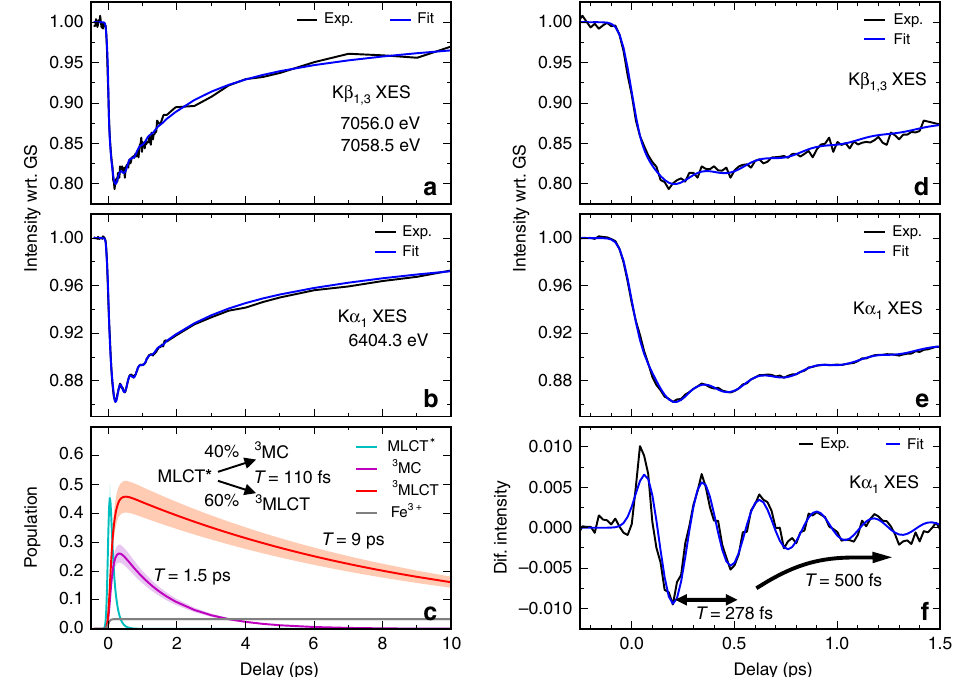
Fig. 3 Combined analysis of the time-resolved K β and K α XES data. a , b Fits of XES time dependence with the three-state branching model discussed in the main text (data: black lines; fi ts: blue lines). c Electronic excited states populations derived from the fi t with 84% excitation yield (MLCT*: cyan; 3 MC: magenta; 3 MLCT: red; Fe 3 + : gray). Shaded areas correspond to an excitation yield range of 74 – 94%. Inset shows the derived population kinetics model: MLCT* decays with 110 fs by branching into the 3 MLCT (60%) and into the 3 MC (40%) states. τ is the lifetime of the respective transient excited states ( 3 MC: 1.5 ps; 3 MLCT: 9 ps). d , e Fits of early time dynamics exhibiting oscillatory signal. f Oscillatory K α XES signal after subtraction of the non-oscillatory part. T is the oscillation period and τ is the lifetime of the oscillations (damping